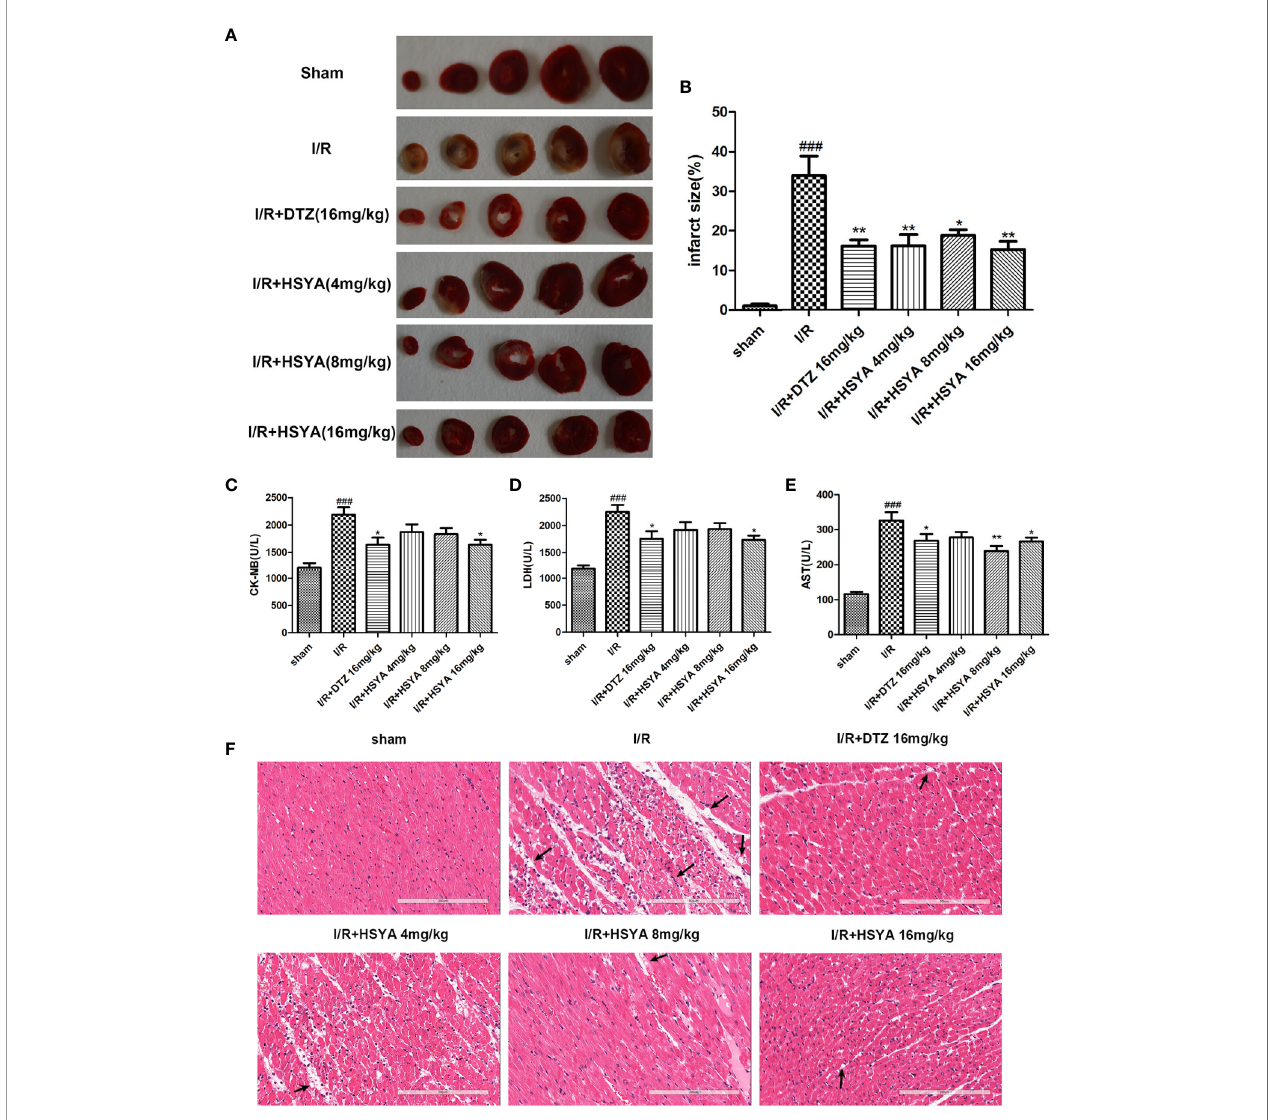
FIGURE 1 | Hydroxysaf fl or yellow A (HSYA) alleviates I/R induced cardiac impairment. (A, B) The representative images and analysis results of triphenyl tetrazolium chloride (TTC) staining (n=4 per group). (C – E) Effects of HSYA on serum creatine kinase-MB (CK-MB), aspartate transaminase (AST), and lactic dehydrogenase (LDH) levels in the rats subjected to ischemia/reperfusion (I/R) injury (n=10 per group). (F) The representative images of H&E staining (Scale bar, 200 m m, n=4 per group). Data are presented as means ± SEM. ### P < 0.001 vs . the sham group, *P < 0.05, **P < 0.01 vs . the I/R